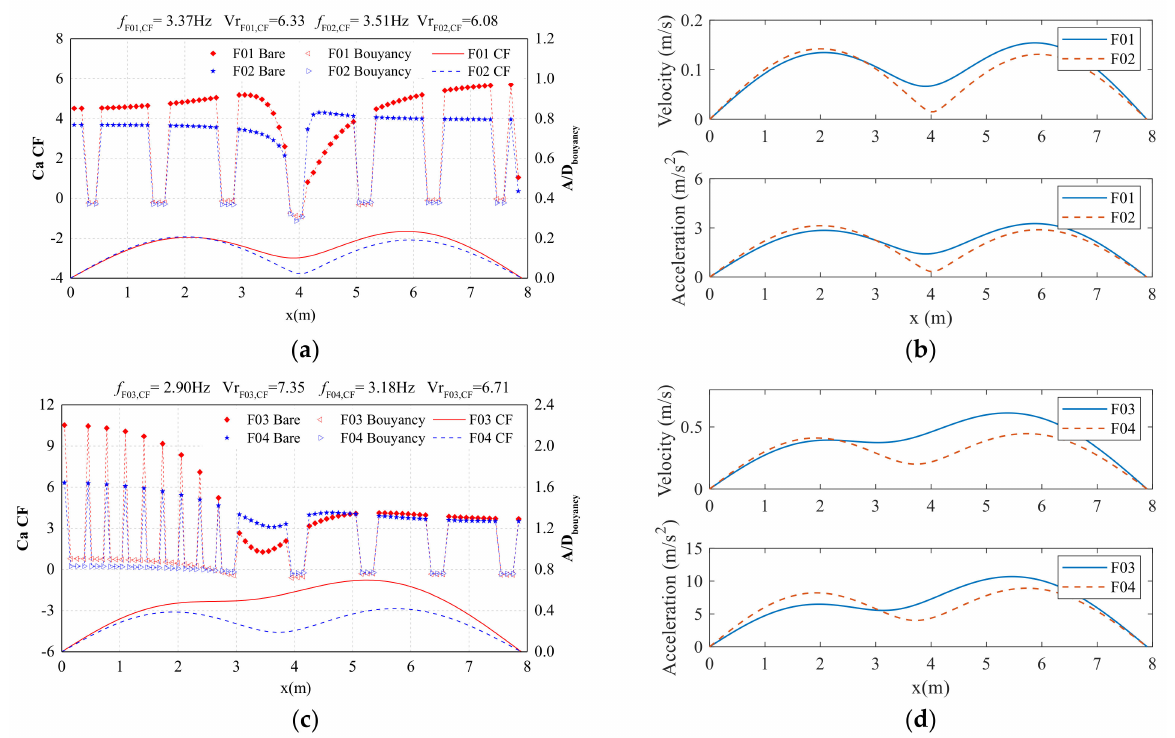
Figure 9. ( a ) Added mass coefficients and A/D for F01 and F02. ( b ) Velocity and acceleration of F01 and F02. ( c ) Added mass coefficients and A/D for F03 and F04. ( d ) Velocity and acceleration of F03 and F04. Added mass coefficient distribution under uniform flow with velocity of 1.6 m/s (Ca CF: added mass coefficient in CF direction; A/D bouyancy is the ratio of VIV displacement amplitude to outer diameter of buoyancy module; f F01,CF , f F02,CF , f F03,CF and f F04,CF are the dominant VIV frequencies of F01, F02, F03 and F04 in CF direction; Vr F01,CF , Vr F02,CF , Vr F03,CF and Vr F04,CF are the reduced velocities referring to f F01,CF , f F02,CF , f F03,CF and f F04,CF